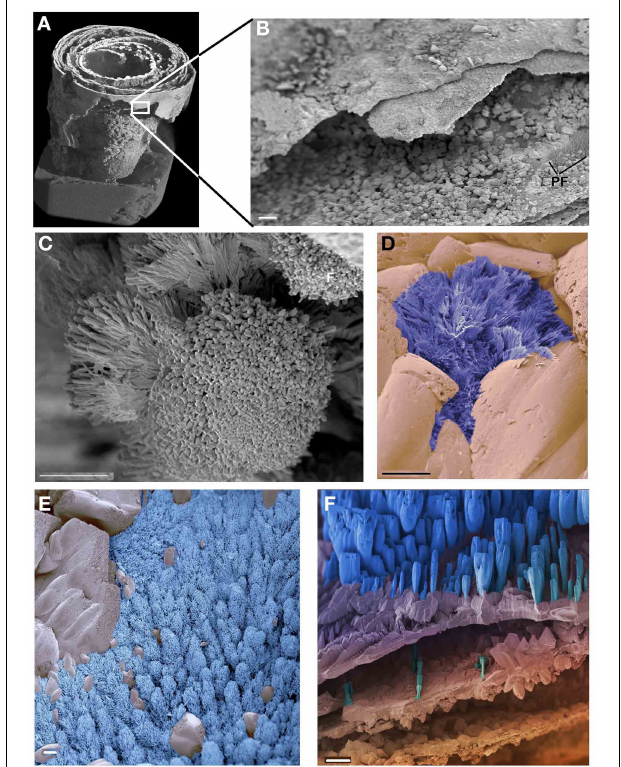
FIGURE 4 | SEM of the CaCO 3 stalactite. (A) General built. Image identical to Figure 3A but non-linearly compacted as it only serves to highlight the position of image (B) . (B) Detail of the outer, smooth surface of the stalactite showing the much coarser built of the more interior layers inside. Low resolution of an area covered in the shrub called “pine forest.” (C–F) The different types of shrubs identified in the CaCO 3 stalactite. (C) The “cauliflower” the most dominantly present. (D) The “Chinese fan” (dark blue) (E) the “pine forest” (light blue). (F) The “amphora” (blue). No logical pattern of presence could be deduced for any of these shrubs. Scale bars (B) and (F) : 100 μ m, (C–E) : 10 μ